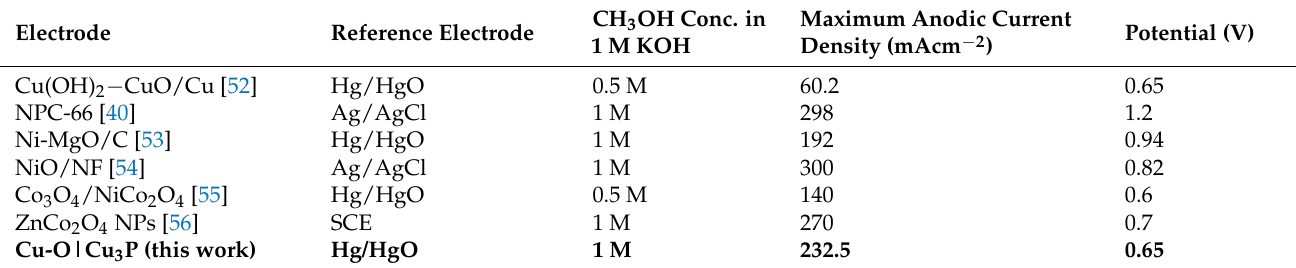
Table 1. MOR performance comparison of the Cu 3 P|Cu-O grown over Cu Foil with other reported free-standing electrodes.